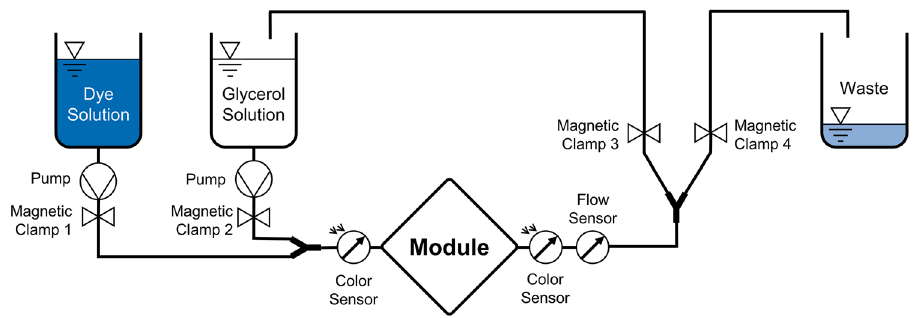
Figure 8. Schematic of the washout test